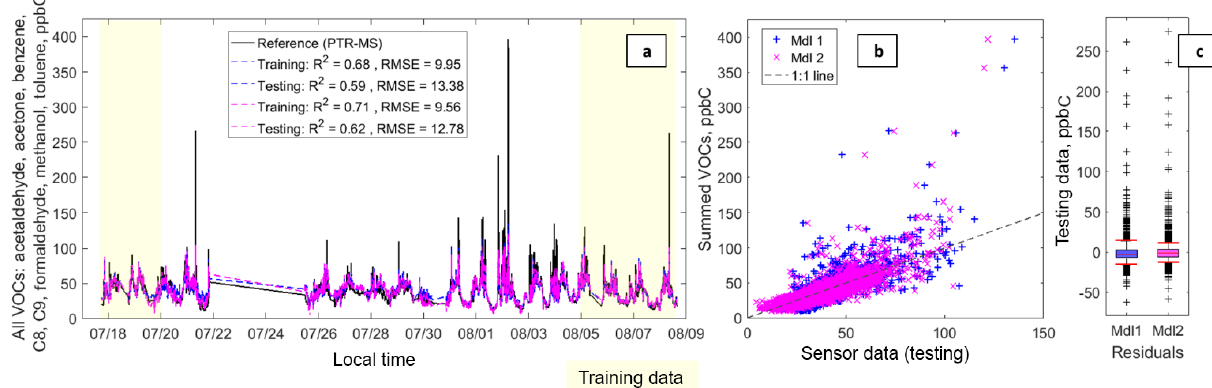
Figure 4. Panel (a) depicts a time series including the summed VOC data from the PTR-QMS (acetaldehyde, acetone, formaldehyde, methanol, and the aromatic species) and the fitted sensor data from Model 1 (in blue) and Model 2 (in fuchsia). The text box includes the following statistics: coefficient of determination ( R 2 ) and the root-mean-squared error (RMSE) in that order for each testing and training dataset. Panel (b) depicts a scatter plot of the testing data for Model 1 (in blue) and Model 2 (in fuchsia); the 1:1 line has also been added. Panel (c) depicts box plots of the residuals with the whiskers at the fifth and 95th percentiles (in red).